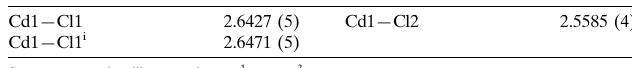
Selected bond lengths (A˚ ).